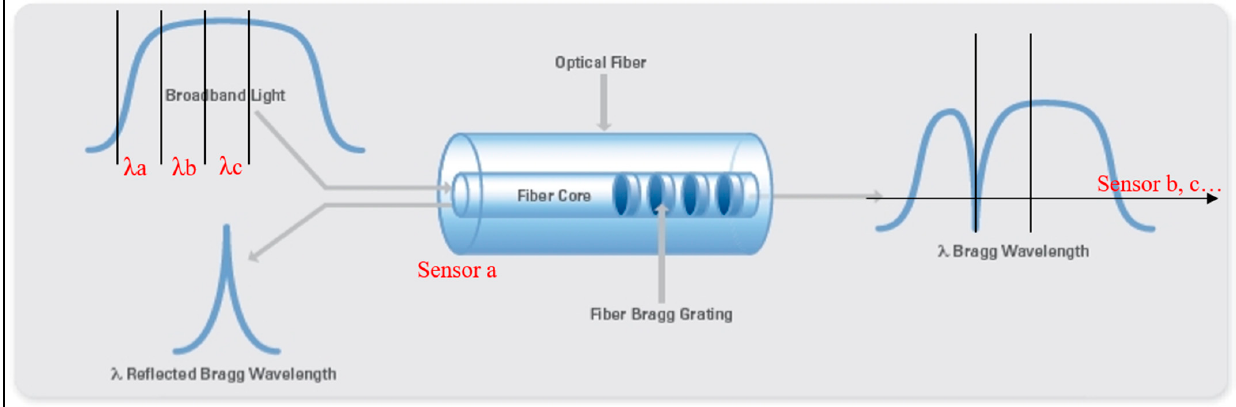
axial strain and temperature result in the Bragg wavelength shifts of gratings, which are